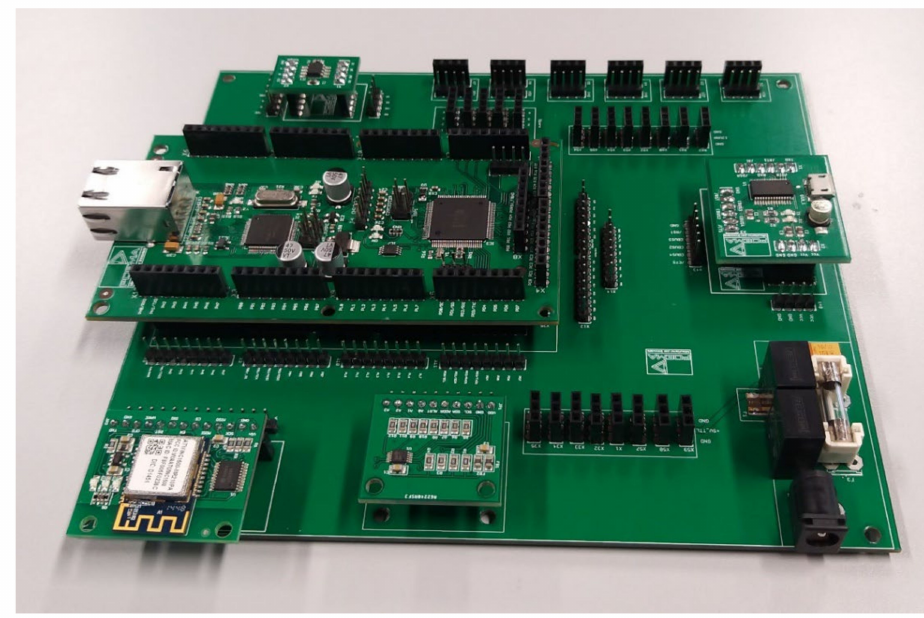
Figure 10. Photo of the electronic board.